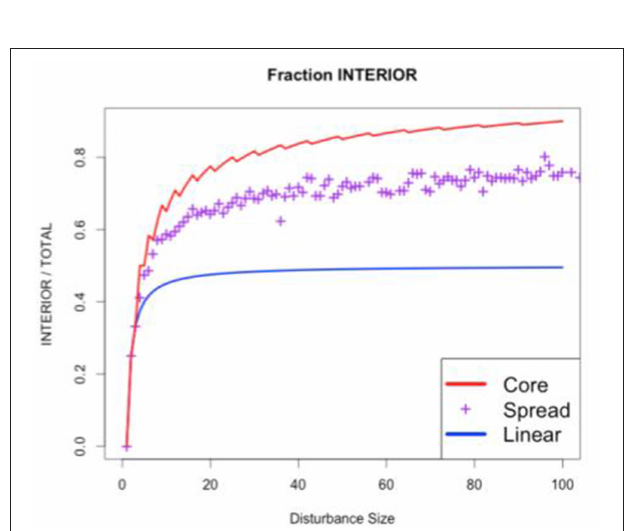
FIGURE 5 | Self-adjacency as a function of disturbance size for different disturbance shapes. Core and Linear are the bounding cases of disturbance shapes that maximize and minimize self-adjacency (respectively). Spread is a single realization of the stochastic contagious spread model ( Figure 2 ).